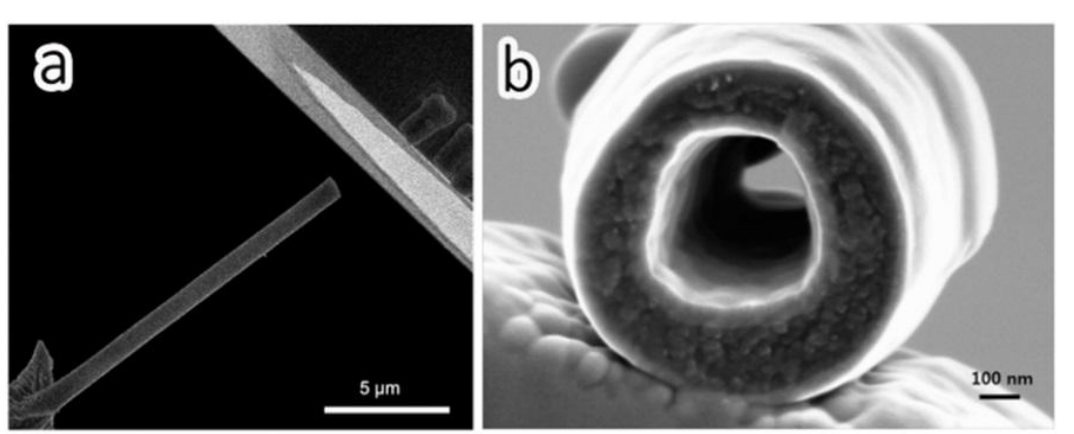
Figure 15. SEM images of ( a ) the fractured hollow CNF; and ( b ) the fractured surface of the hollow CNF [84].